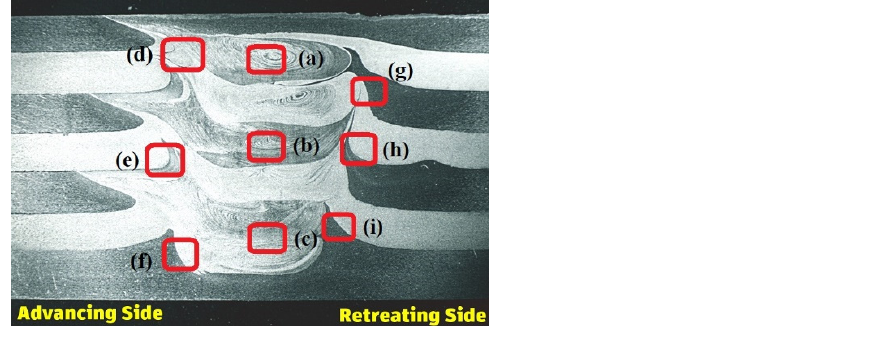
Figure 8. Extraction points for microstructural analysis. (a–c) NZ in upper, middle, and lower layer, (d–f) AS in upper, middle, and lower layer, and (g–i) RS in upper, middle, and lower layer.